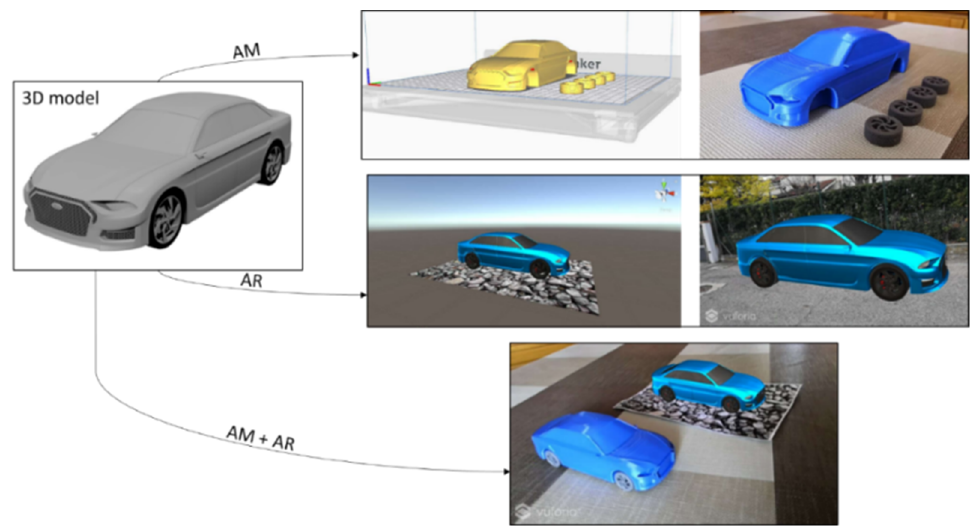
Figure 14. Results achieved from 3D car model in AR and AM.